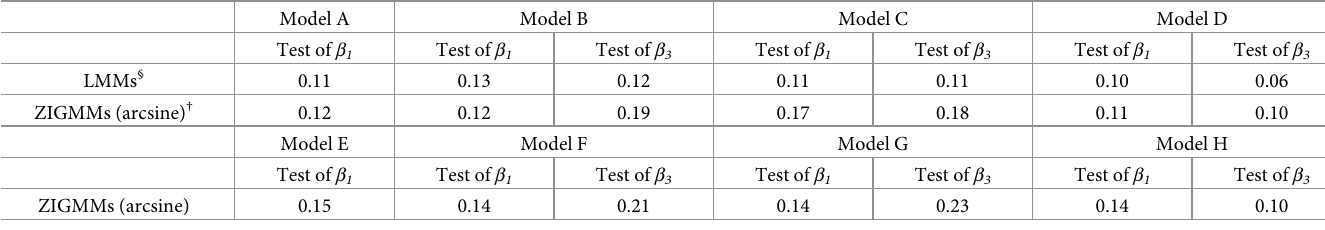
Table 5. Proportions of significant taxa detected in four models with LMMs and ZIGMMs.